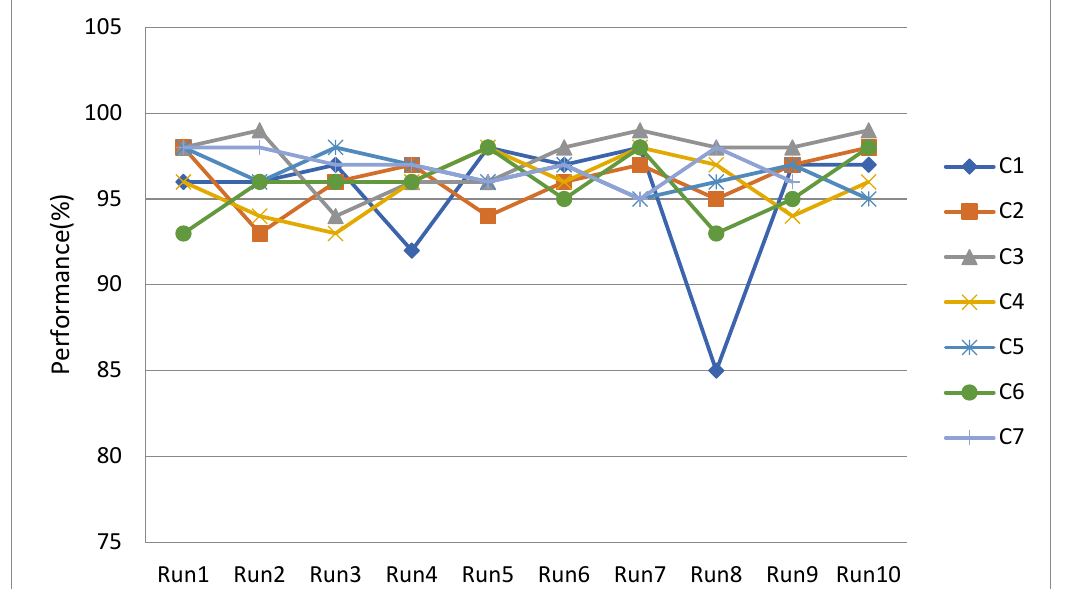
Figure 10. The trend of the sensitivities of each class